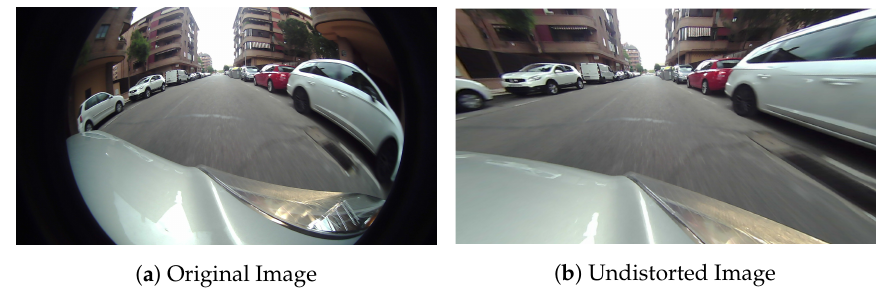
Figure 1. Example of fisheye image